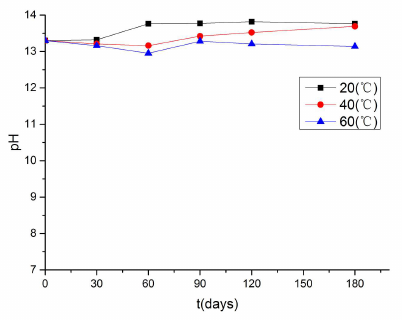
Figure 16. pH value of concrete pore solution versus time.